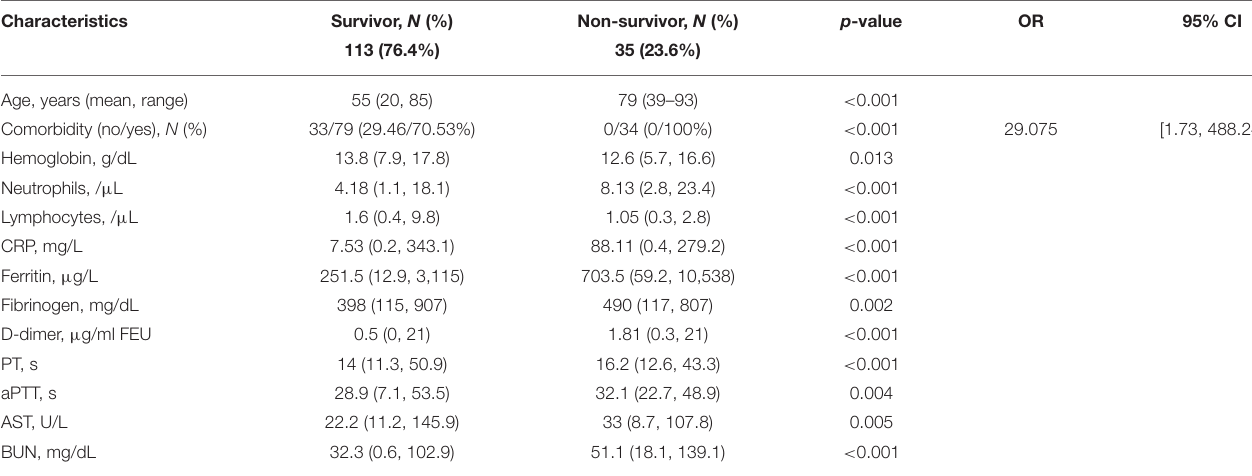
TABLE 5 | Factors associated with mortality in the univariate